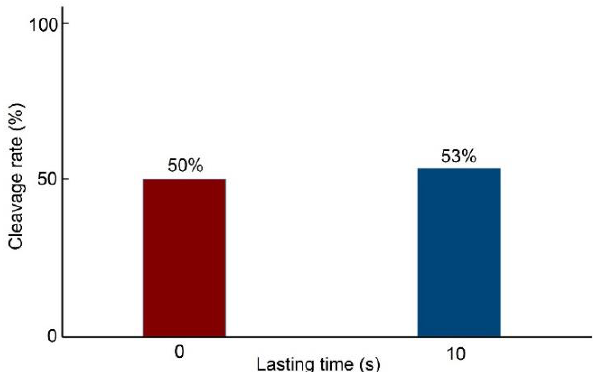
Figure 7. Cleavage rates of embryos in different lasting time